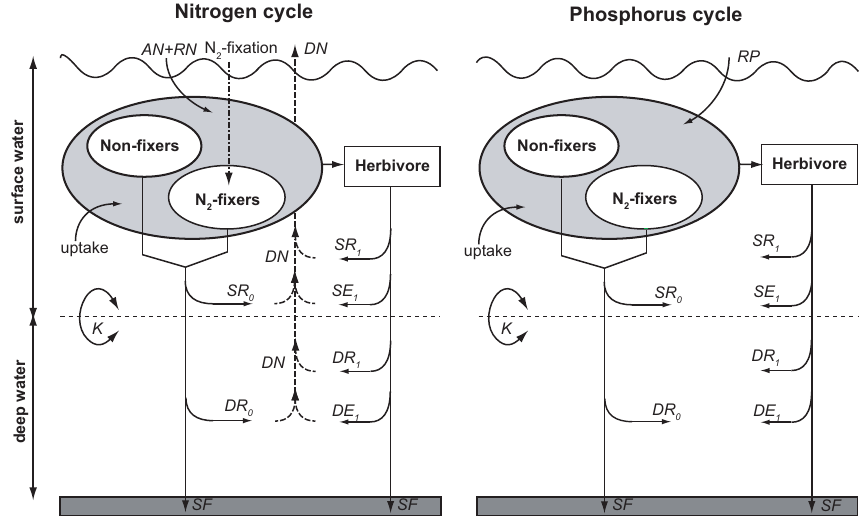
Fig. 1. A modified version of Tyrell’s 2-box model of N and P cycling in the ocean which includes a parameterisation of herbivores. The model parameter abbreviations are described in Table 1.